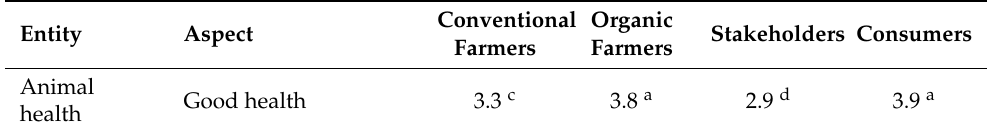
Table 3. The average level of acceptance on a 5-point scale per housing system aspect per respondent